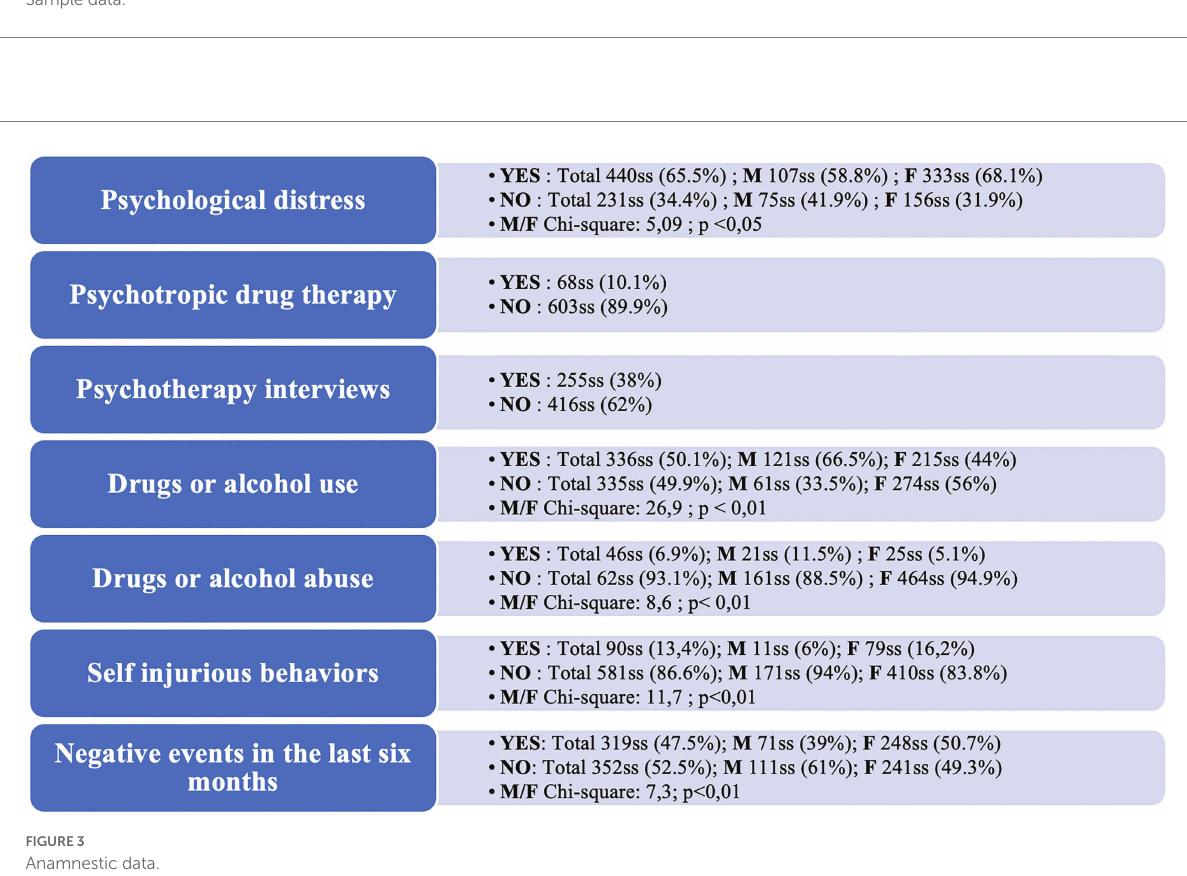
FIGURE 2 Sample data.